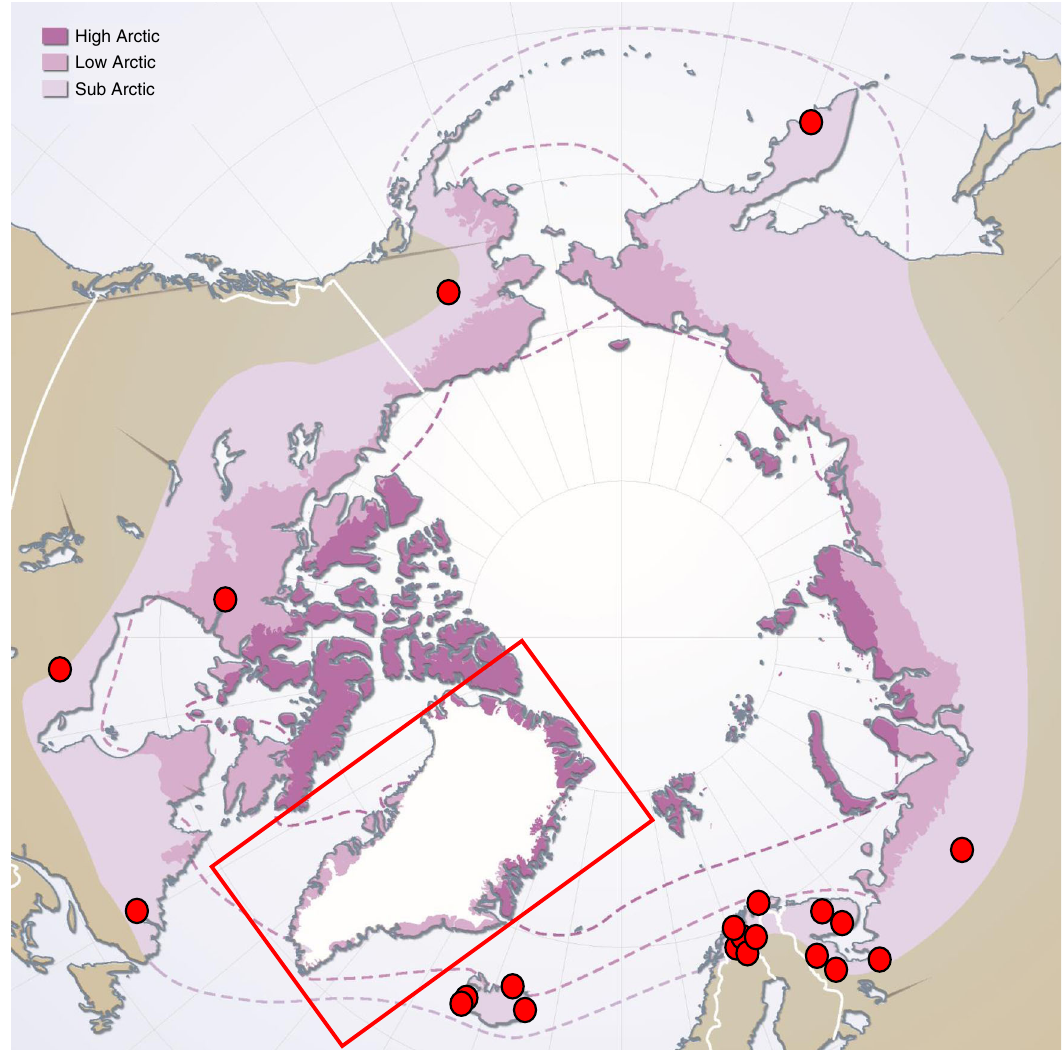
Fig. 1 Documented presence of geoengineering earthworms in the Arctic. Sites (red circles) in which Lumbricus sp. and Aporrectodea sp. have been found (utilizing the mineral soil as a habitat) in the arctic biome (purple shading) divided into three major geographical zones (sub-, low-, and high-arctic). Sites are compiled from previously published studies 27,47,49,52 – 55 and fi ndings presented in the Global Biodiversity Information Facility database. Red rectangle indicates a reported fi nding of L. rubellus in Greenland where the speci fi c site was not reported 56 . The fi gure does not intend to provide a complete overview of known populations of geoengineering earthworms, but to illustrate that they can survive in the Arctic (mainly the sub-arctic zone). A common denominator is that earthworms occur adjacent to human introduction points. Thus, the map illustrates that human mediated introductions occur at circumpolar scale. The underlying map showing geographic areas of the Arctic is derived from the Arctic Biodiversity Assessment (http://grida.no/